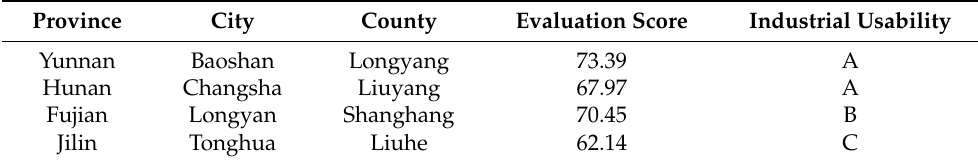
Table 2. Tobacco quality evaluation